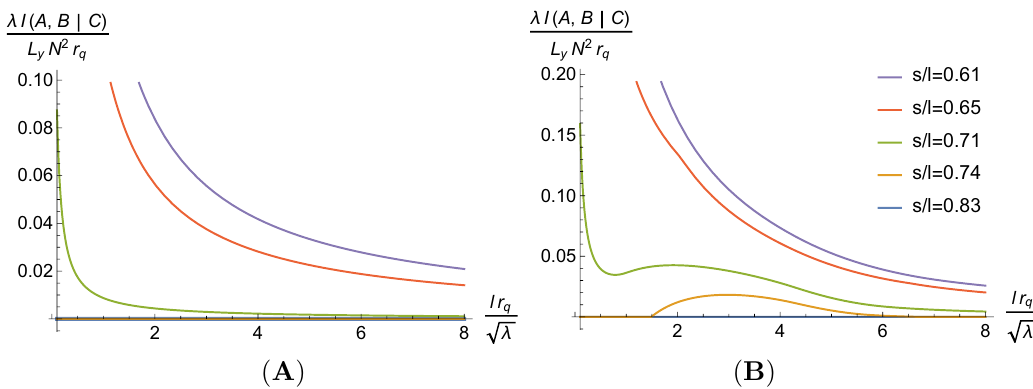
Figure 12 . Conditional mutual information I ( A; B j C ) for strips A , B , and C separated by spacing s , as a function of changing strip width l with s=l (cid:12)xed. The strips are ordered with B in the middle as shown in (cid:12)gure 11. ( A ) ABJM theory without quarks. ( B ) ABJM theory with massive